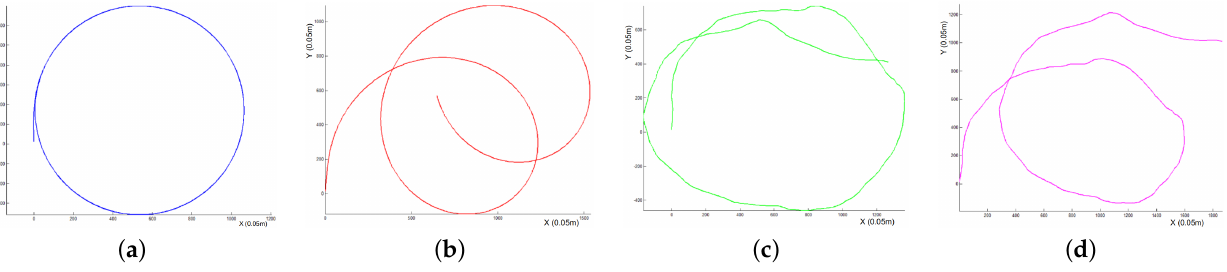
Figure 3. USV turning experiments. ( a ) Turning experiment of a USV without environmental disturbances. ( b ) Turning experiment of a USV with current disturbances. ( c ) Turning experiment of a USV with wind disturbances. ( d ) Turning experiment of a USV with current and wind